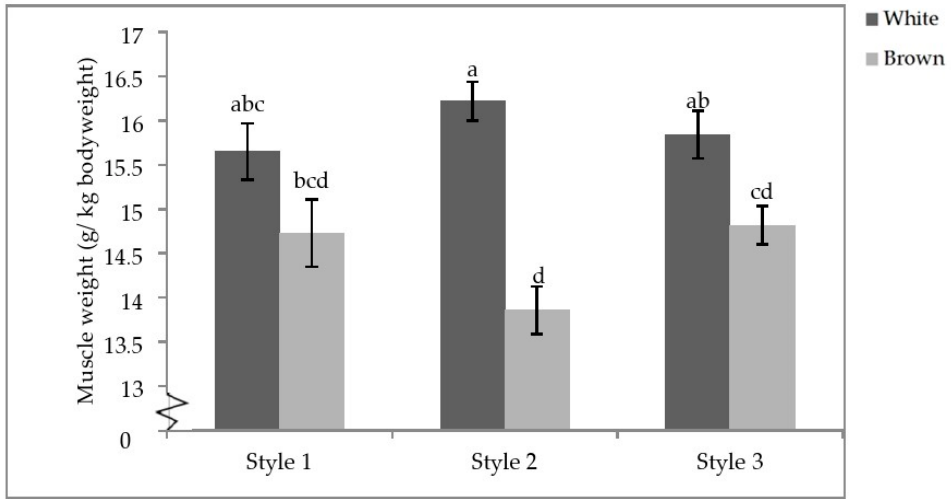
Figure 7. Aviary style by strain colour interaction of pectoral minor weights. Error bars represent standard error. a–d Indicate significant differences between means ( p < 0.05).